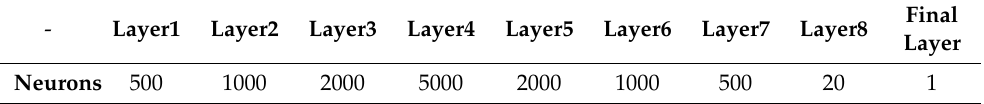
Table 1. Architecture of the “large” feedforward network model